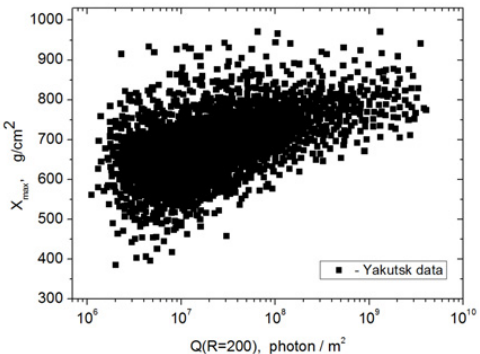
Figure 1. Dependence of X max on the classification parameter Q(200)–EAS Cherenkov light flux density at a distance of 200 m from the shower axis. Data obtained in